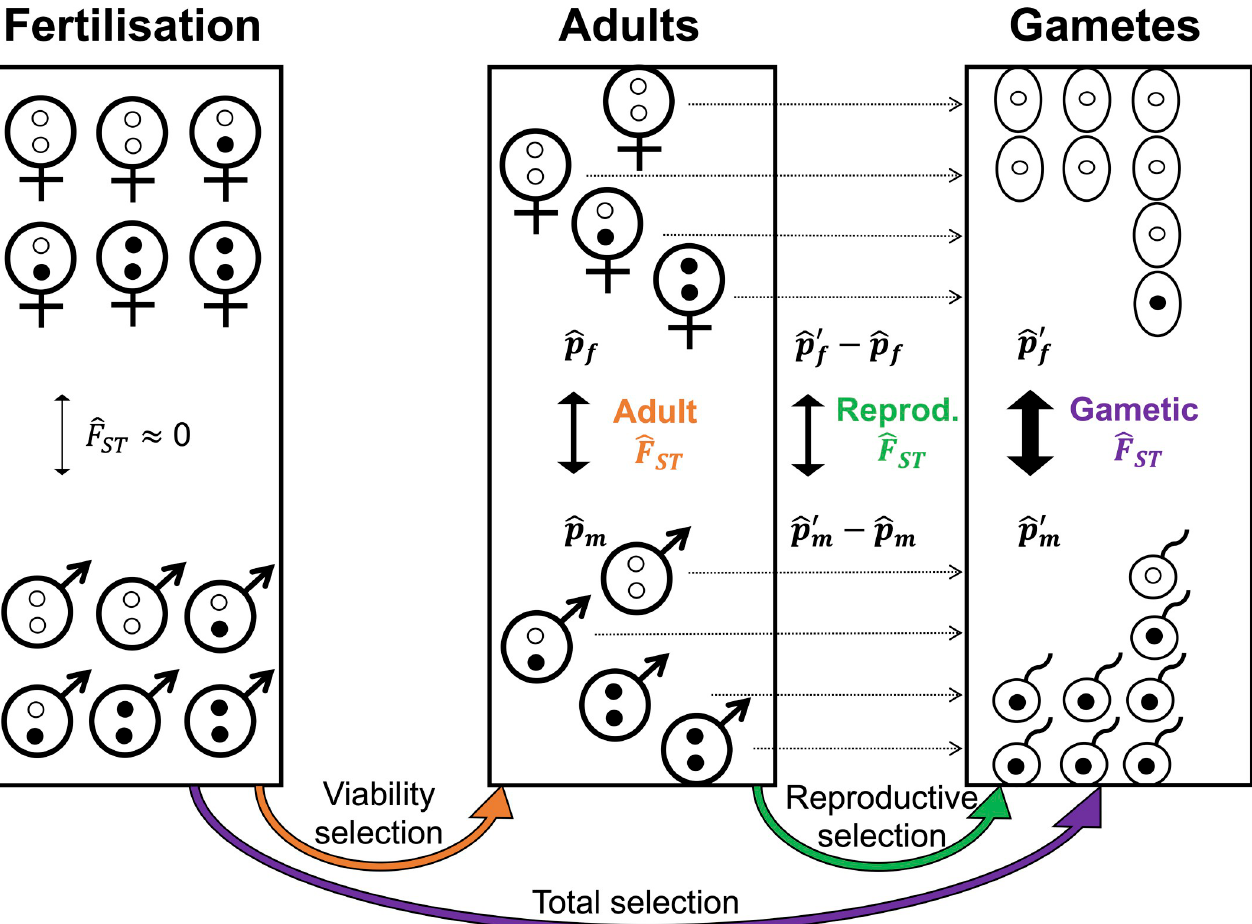
Fig 1. AU : AbbreviationlistshavebeencompiledforthoseusedinFigs 1 (cid:0) 5 : Pleaseverifythatallentriesarecorrect : Partitioning signals of sex differences in selection among fitness components. A pair of autosomal alleles are represented by white and black dots, representing female- and male-beneficial alleles, respectively; ^ p ; ^ p ; ^ p 0 , and ^ p 0 depict sex-specific frequency estimates for a given allele at different stages of f m f m the life cycle (see main text for details). Autosomal allele frequencies are equalised between sexes at fertilisation (left box; females, top; males, bottom), resulting in negligible allele frequency differentiation at this stage of the life cycle. Differentiation between sexes can arise in the sample of adults (middle box) due to sex differences in viability selection among juveniles (orange arrow) and in the projected gametes (right box) due to sex differences in LRS among adults (green arrow). Data on sex-specific allele frequencies and LRS thus allow the estimation of sex-differential effects of genetic variants on each fitness component (including overall fitness; purple arrow), despite the absence of allele frequency data among zygotes (left box) and gametes (right box), which are inferred and not directly observed. LRS, lifetime reproductive success.